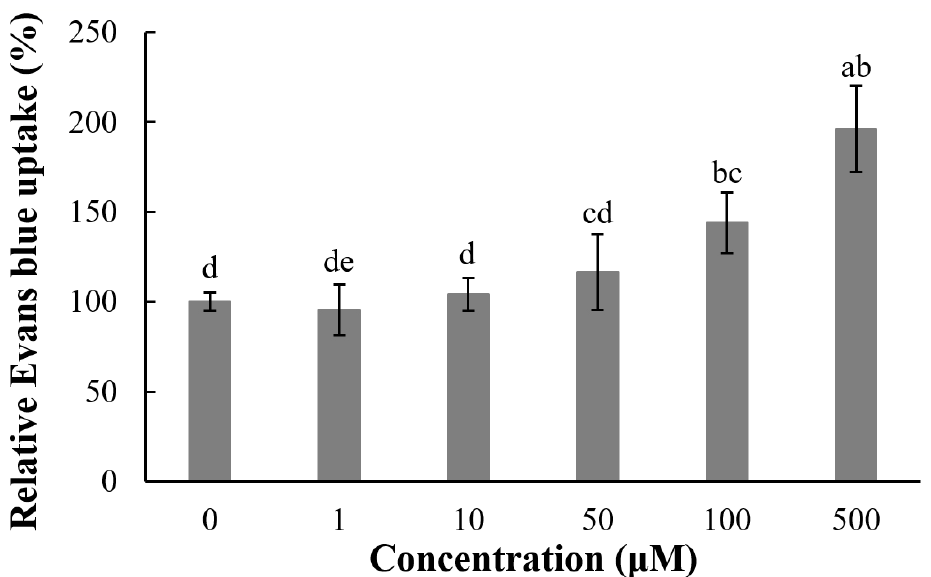
Figure 4. Cell viability in lettuce root tips after treatments with acacetin. Lettuce seedlings were treated with acacetin at concentrations of ( A ) 0, ( B ) 1, ( C ) 10, ( D ) 50, ( E ) 100 and ( F ) 500 μ M for 48 h. Roots were stained with FDA/PI. Green fluorescence and red fluorescence indicate viable and dead cells in root tips, respectively. Bar = 500 μ m.